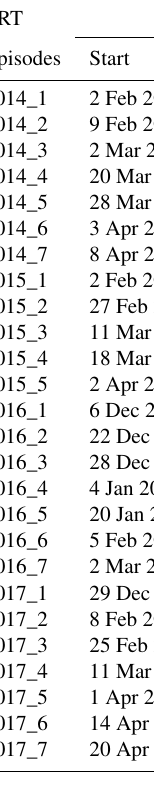
Table 1. List of African LRT episodes observed at the ATTO site from February 2014 until April 2017. The mean and maximum M 1–10 values characterize the relative intensity of the dust pulses. For LRT episodes that contain larger data gaps, the M 1–10 values were put in parentheses. Note that the mean and maximum M 1–10 values shown here are based on a density of 1gcm − 3 , see further information in Sect. 2.3. Since typical densities of dust and sea salt components in the LRT plumes are higher (see Table S1), the shown M 1–10 values represent lower limit values (compare Table